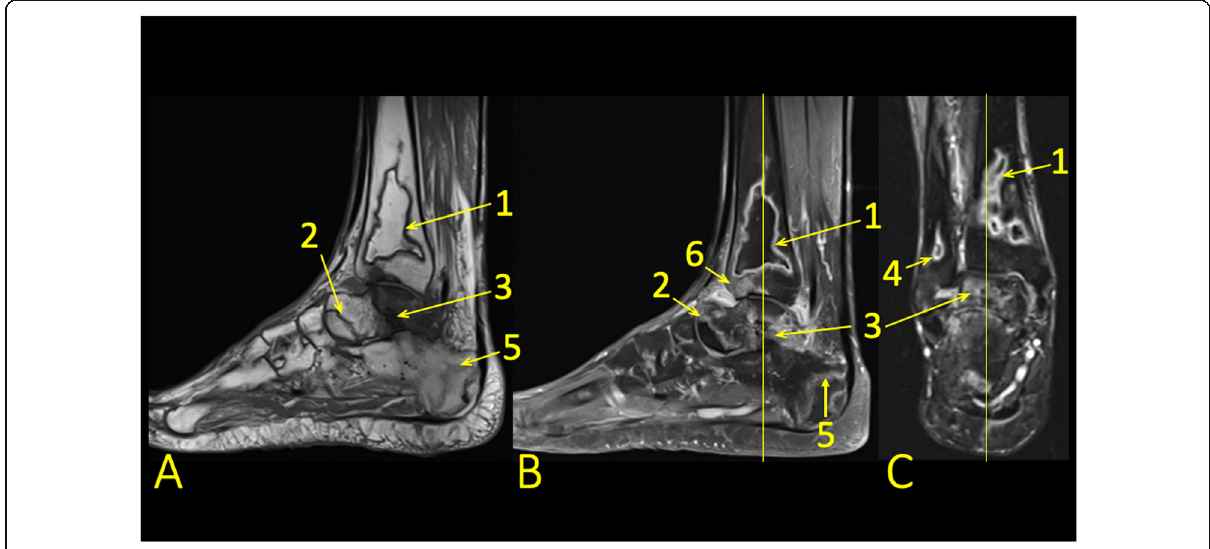
Fig. 16 A 45-year-old male, 2years after kidney transplantation, presented with 6-week history of ankle pain and a suspected talar stress fracture. MRI showed bone infarcts in the distal tibia (1), fibula (4), talus (2), and calcaneus (5) and a talar fracture (3). BME in the subchondral part of the distal tibia